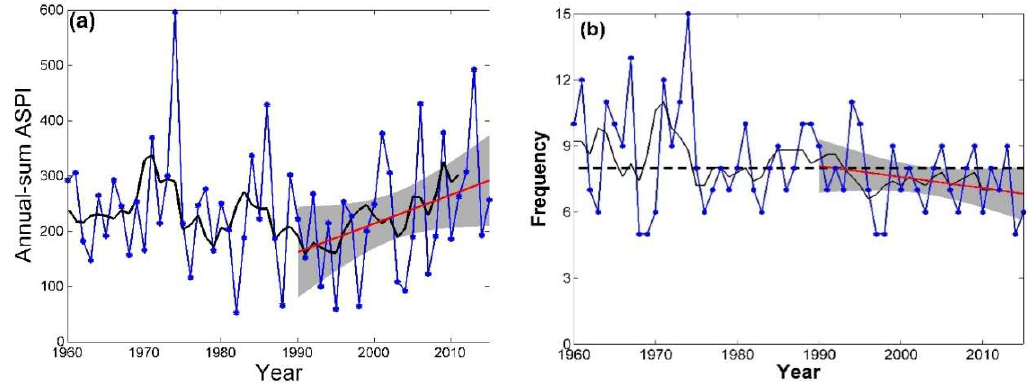
Figure 2. Time series of ( a ) annual-sum ASPI, ( b ) frequency of landfall TCs along the southeastern coastline of China from 1960 to 2015, derived from Japan Meteorological Agency (JMA). Thick black lines are the 5-year running average with the red line schematically indicating trends. Shading shows 95% confidence bounds. Dotted black line in ( b ) is the average frequency of landfall TCs.